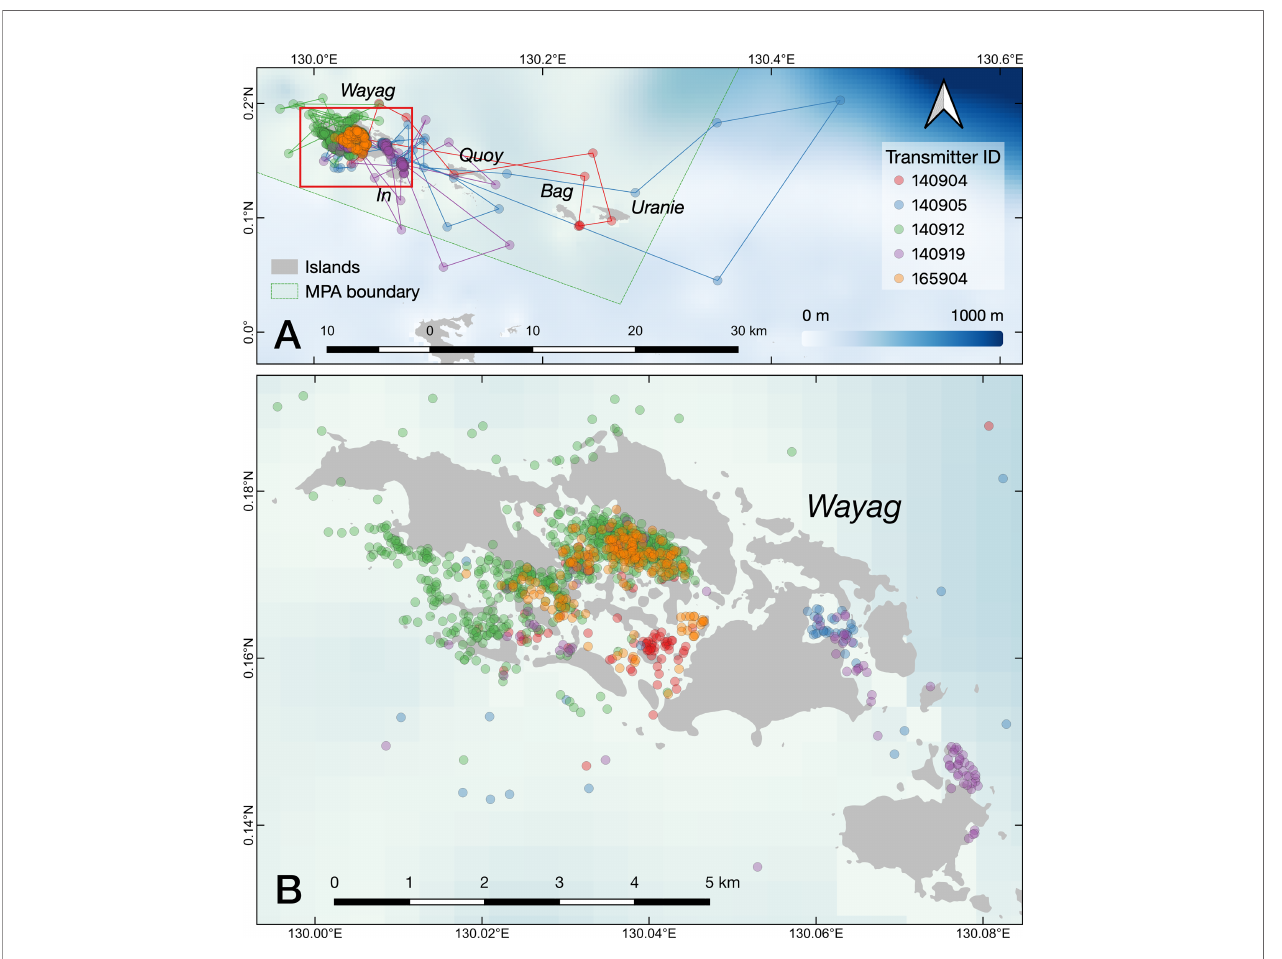
FIGURE 3 | The raw movement tracks (lines) derived from GPS locations (dots) recorded by the satellite transmitters on the fi ve tagged juvenile M. alfredi . (A) the SAP Waigeo Barat MPA with names of the islands; (B) a close up of the Wayag